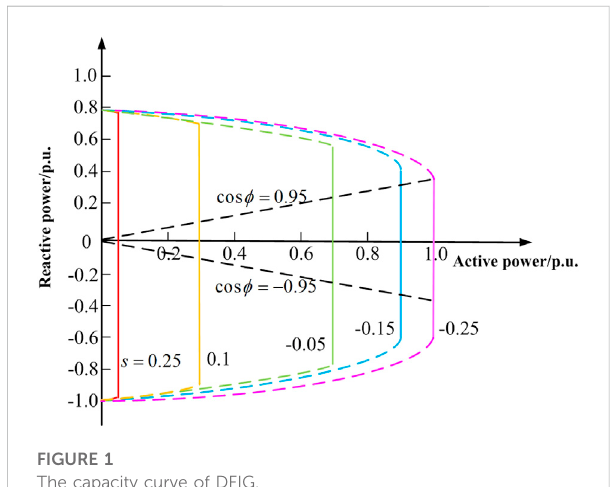
FIGURE 1 The capacity curve of